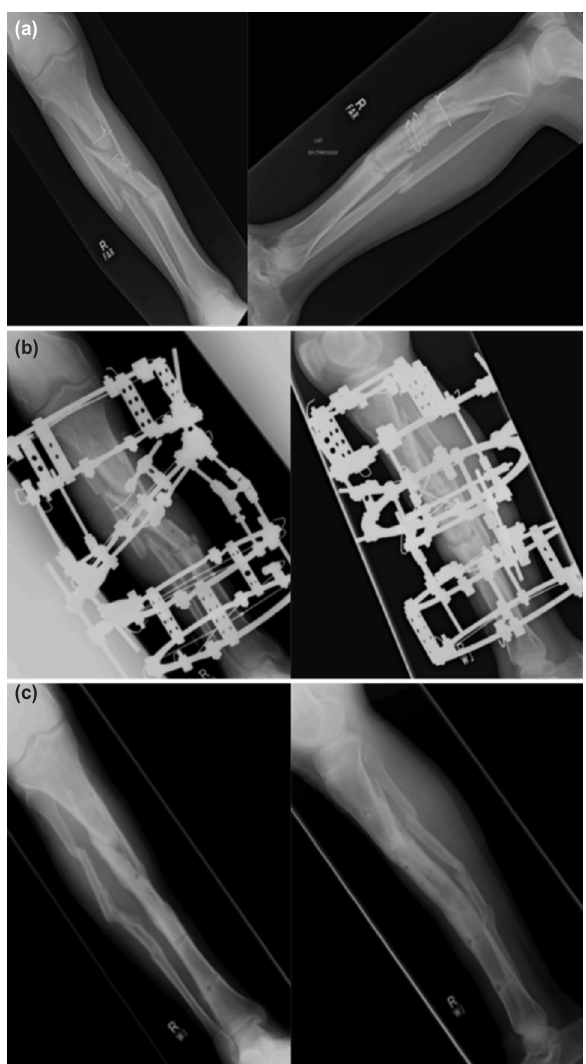
Radiographs of Patient 1. (a) Pre-operative antero- Fig. 1: posterior and lateral views showing tibial non-union. (b) Post-operative antero-posterior and lateral views after Ilizarov application. (c) Antero-posterior and lateral views at the time of final follow-up showing bony union.